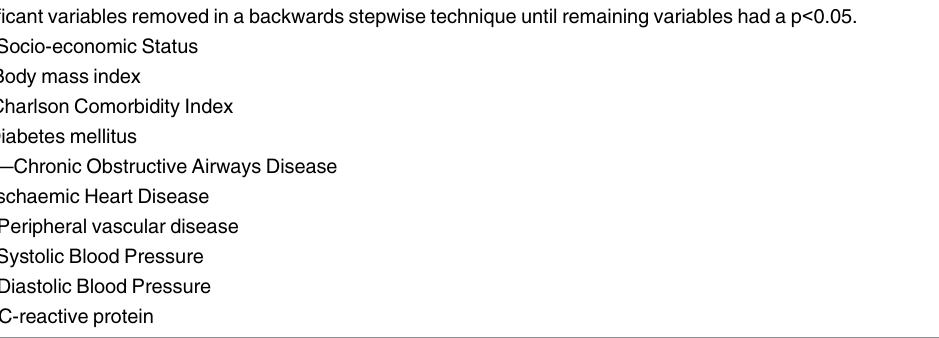
HRQL: male gender; currently in employment; not smoking in comparison to current smok- ing; lower BMI; less comorbidity; and lower CRP (Table 8). This linear regression model explained 20.8% of the variability in HRQL as assessed by the EQ-5D